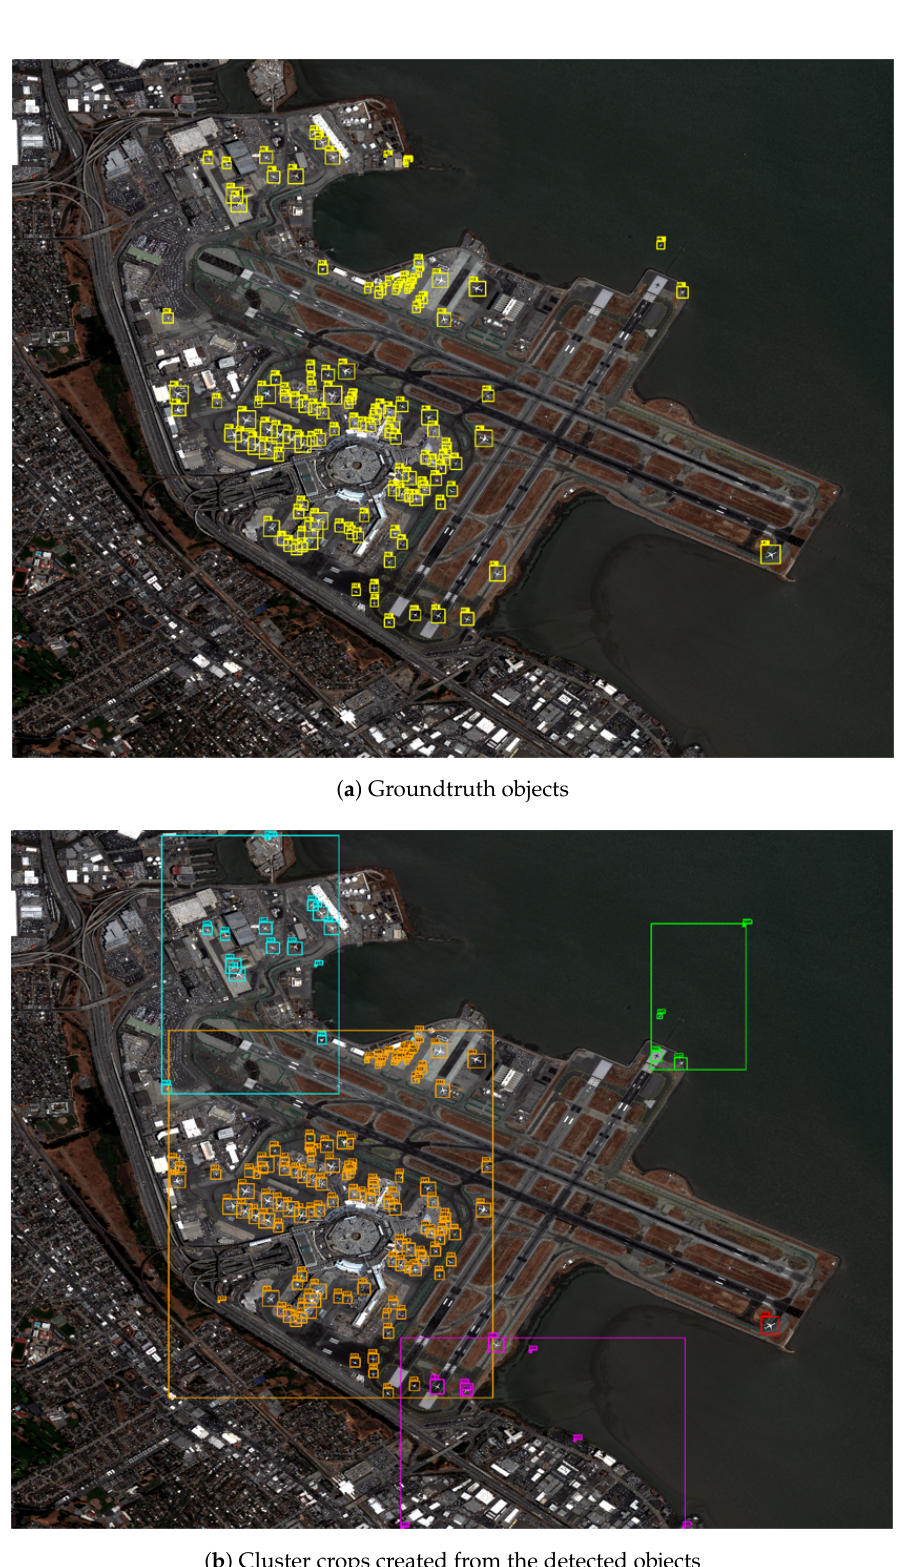
Figure 9. Example cluster crops on the satellite image taken from the airport-peripheral areas. Each generated cluster crop and the associated object proposals are indicated by the same color. These WorldView-3 images are provided by DigitalGlobe